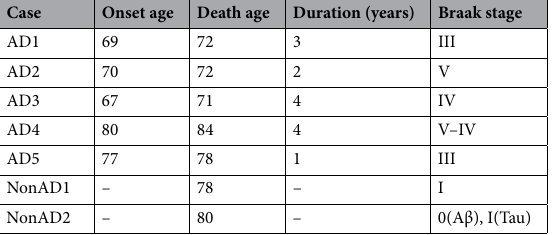
Table 1. The information of AD cases and controls in validation